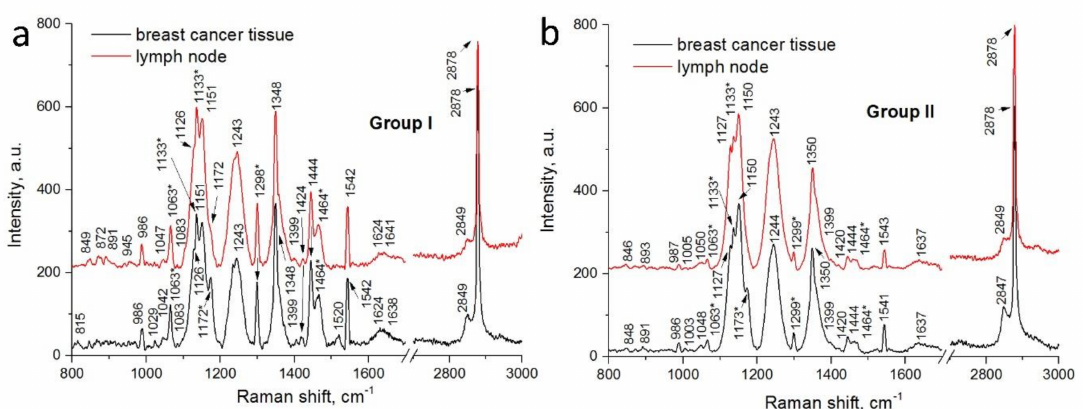
Figure 2. Average Raman spectra of the breast cancer tissues and LNs collected from patients of the ( a ) I and ( b ) II groups. The Raman bands typical for para ffi n are marked with